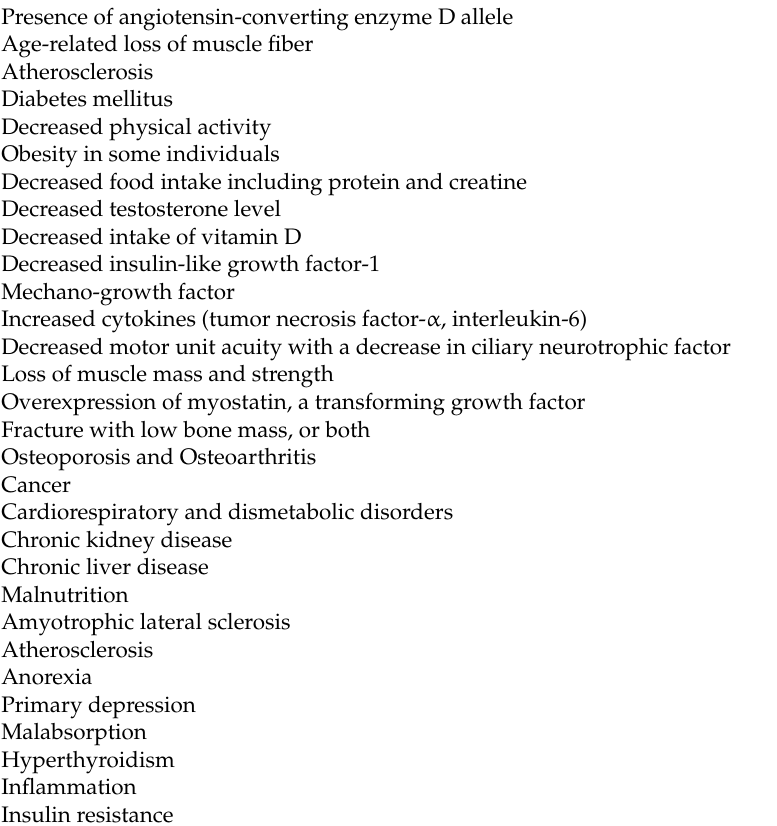
Table 1. Possible diseases associated with